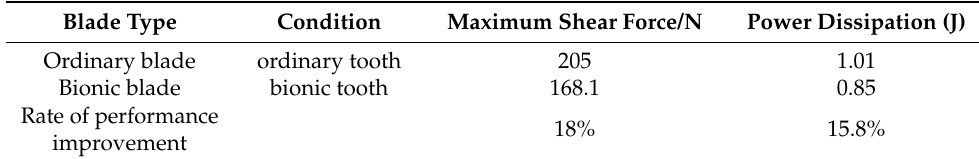
Table 7. Performance comparison results between an ordinary and a bionic blade.